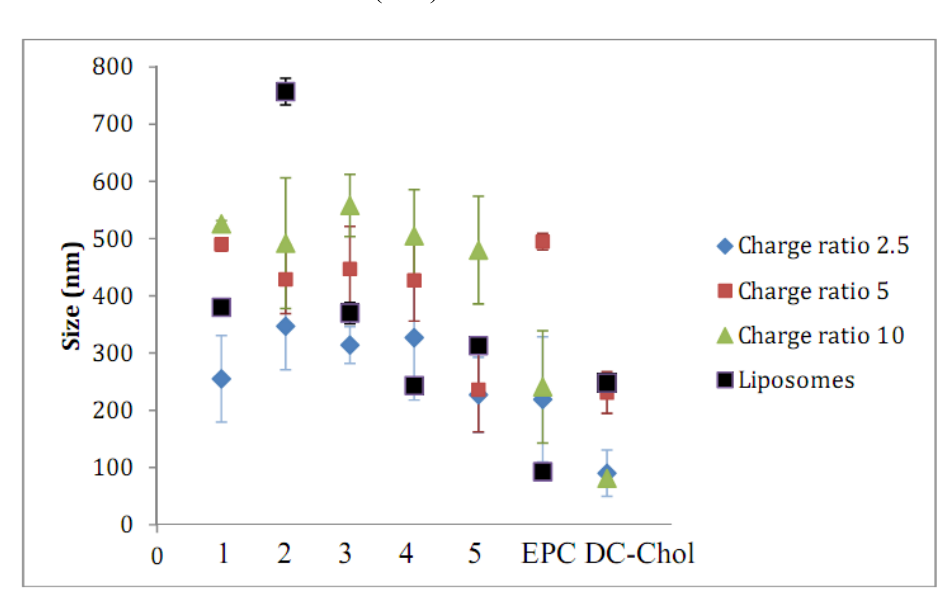
Figure 3. Liposome and lipid-siRNA lipoplex particle sizes were determined by dynamic light scattering at 25 °C at a detection angle of 90°. Separate hydrated liposome solutions (from sterile water) composed of cationic lipid/DOPE (3:2 mole/mole ratio) were generated in duplicate for each carotenoid lipid, 1 – 5 , as well as for control lipids EPC and DC-Chol, and each sample was analyzed in triplicate. The corresponding liposome-siRNA lipoplexes were prepared in OPTI-MEM ® buffer at (+/ − ) molar charge ratios 2.5, 5 and 10. All data are the mean ± standard error (S.E.) of three measurements for two different